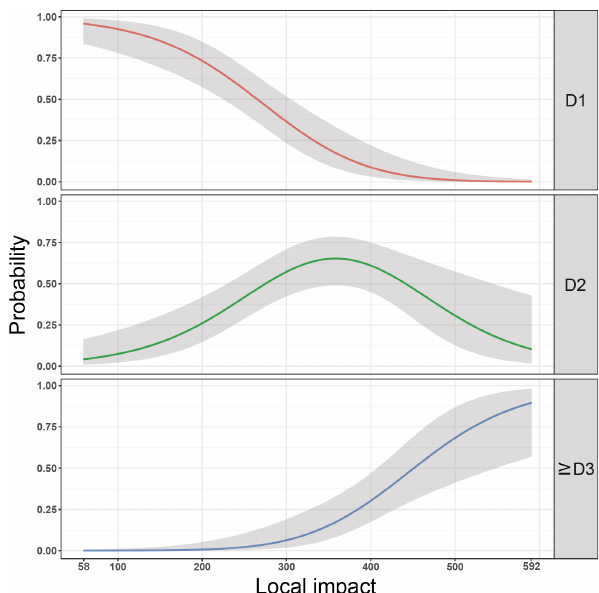
Figure 4. Probabilities of the damage grade predicted by the multi- nomial logistic regression model (see Table 2 and Sect. 2.3.2 for de- tails on the damage grades and the local impact indicator). It can be seen how the probability for a specific group affinity changes with an increasing local impact value and shifts towards higher damage grades.